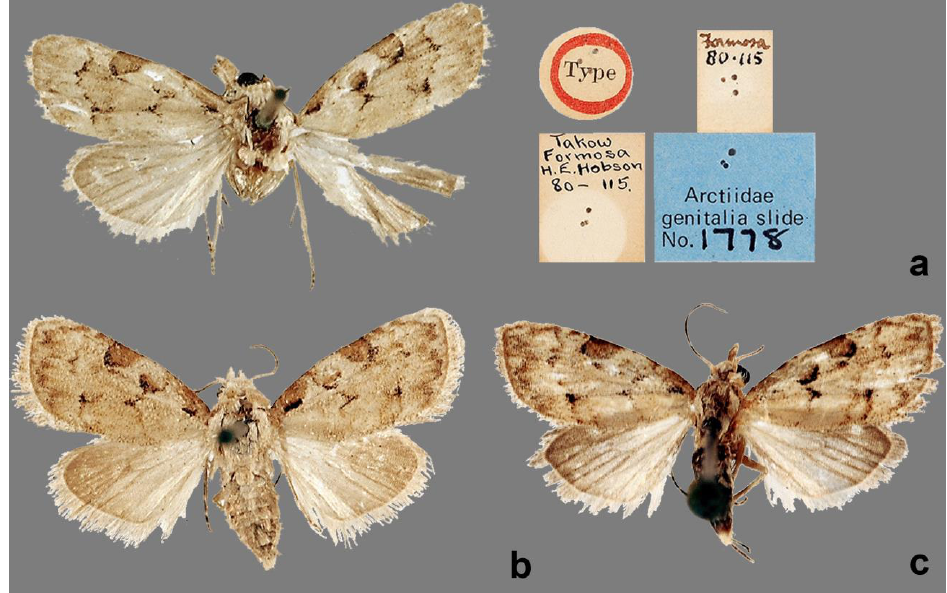
Figure 2. Adult and label illustrations of Nola innocua Butler, 1880 ( a ) N. innocua , female, holotype (NHMUK, Arctiidae genitalia slide No. 1778); ( b ) Ditto , female, (NHMUK, gen. slide No. LGN 1903); ( c ) Ditto , male, (MWM/ZSM, gen. slide No. LGN 1902).